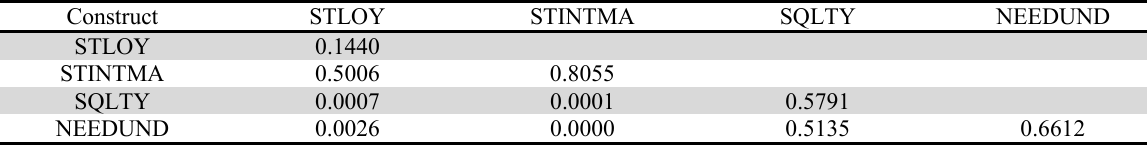
Discriminant Validity (Fornell and Lacker’s criterion) Construct